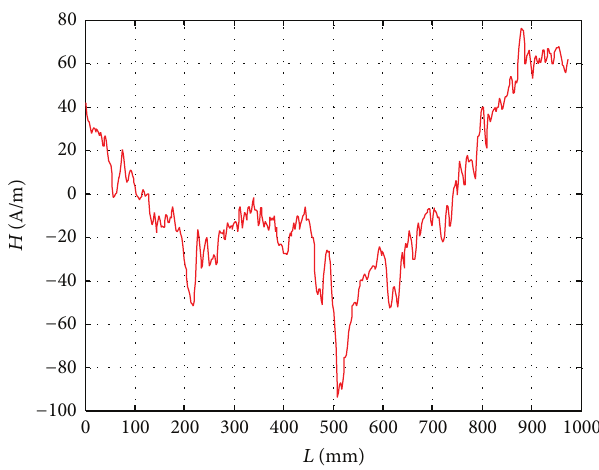
Figure 4: MMM signal of casing after stress test.